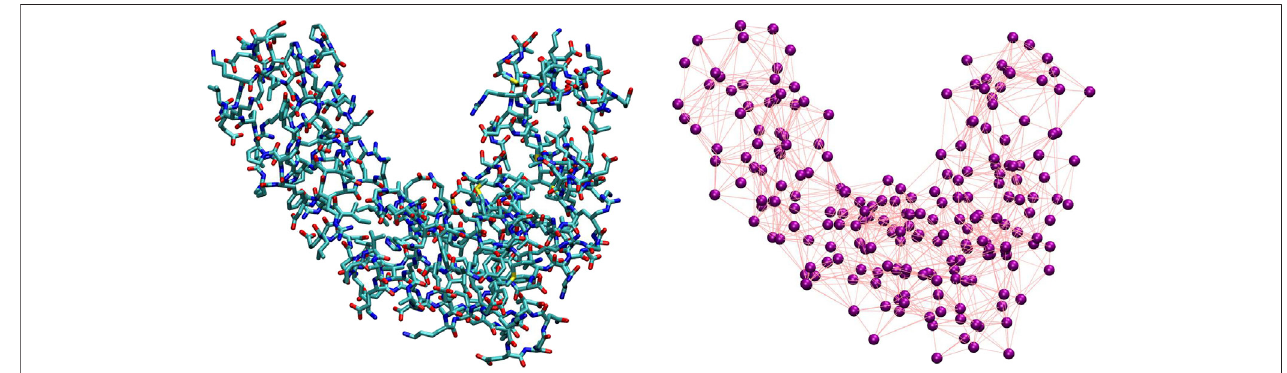
FIGURE 2 | Comparison between an all-atom, detailed description of a protein (left) and one of its possible coarse-grained representations (right) . The purple spheres on the right plot correspond to CG sites, while the edges connecting them represent the effective